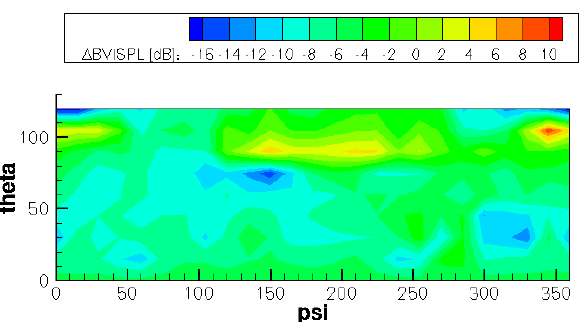
Figure 11: Technique A – B differential BVISPL at point 1 in maneuver ID8021.